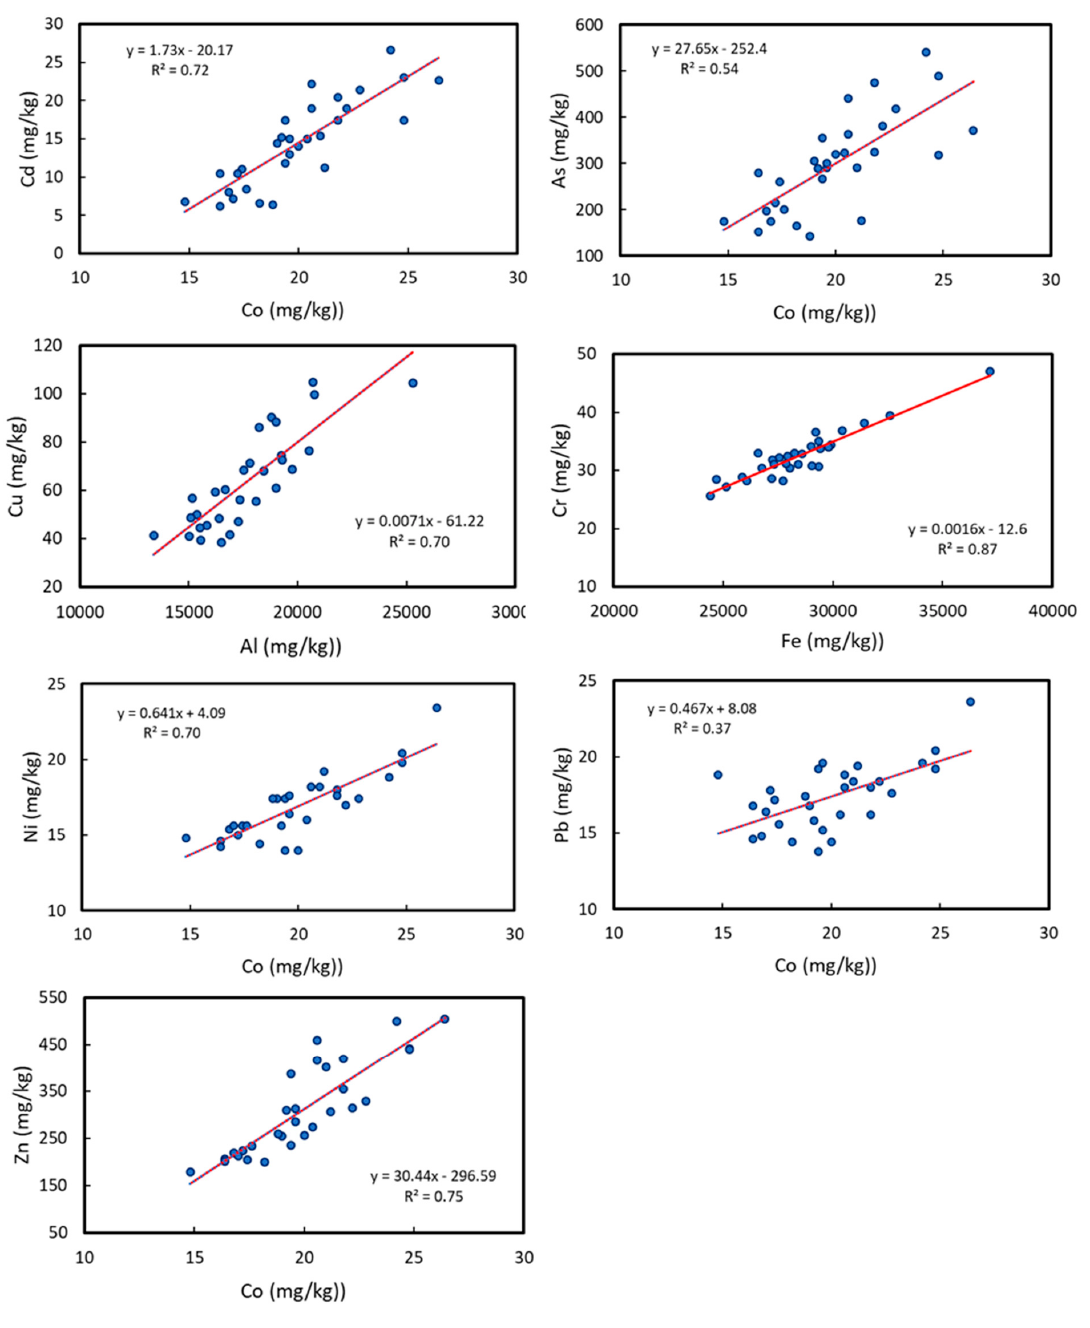
Figure 10. Background functions for the seven analyzed trace metals calculated for reach RS. Analysis considered Al, Fe, and Co. Selected background function was based on strength and significance of the regression